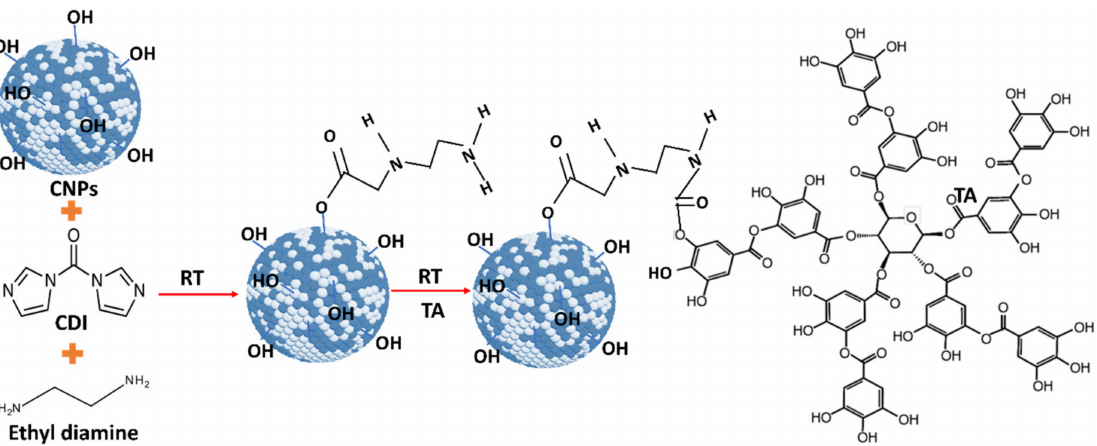
Figure 1. Schematic diagram representing the cerium oxide (CNPs) and tannic acid (TA) conjugation by imidazole chemistry at room temperature. Initially, the hydroxyl group (OH) on the CNP surface was activated by 1, 1 (cid:48) -carbonyl diimidazole (CDI) followed by ethylene diamine (EDI) added to the activated CNP solution. One end of the amine group EDI is attached to the active imidazole carbamate intermediate, and another end is attached to a hydroxyl group in TA molecules to form two carbamide bonds to conjugate TA and